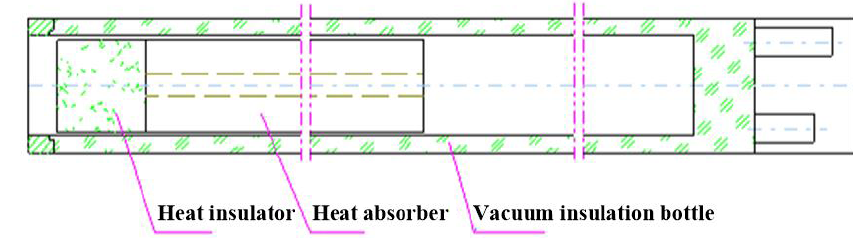
Figure 18. Structural diagram of the metal vacuum flask.